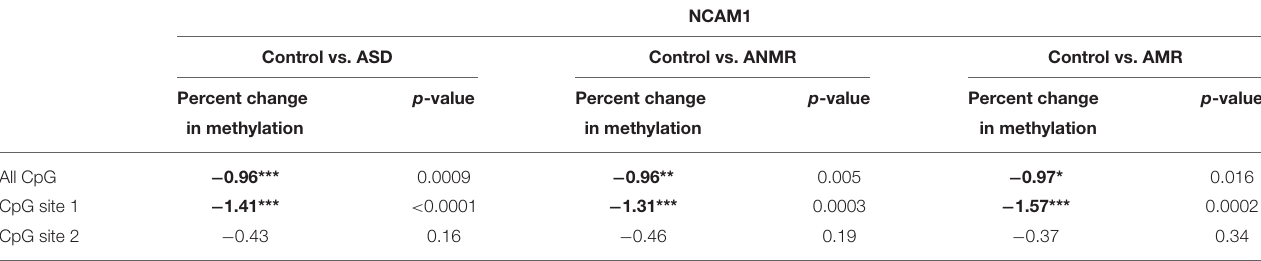
TABLE 4 | Pyrosequencing results of NCAM1 showing percent change in methylation in ASD group, ANMR and AMR subgroups compared to healthy control group. NCAM1 Control vs. ASD Control vs. ANMR Control vs. AMR Percent change p -value Percent change p -value Percent change p -value in methylation in